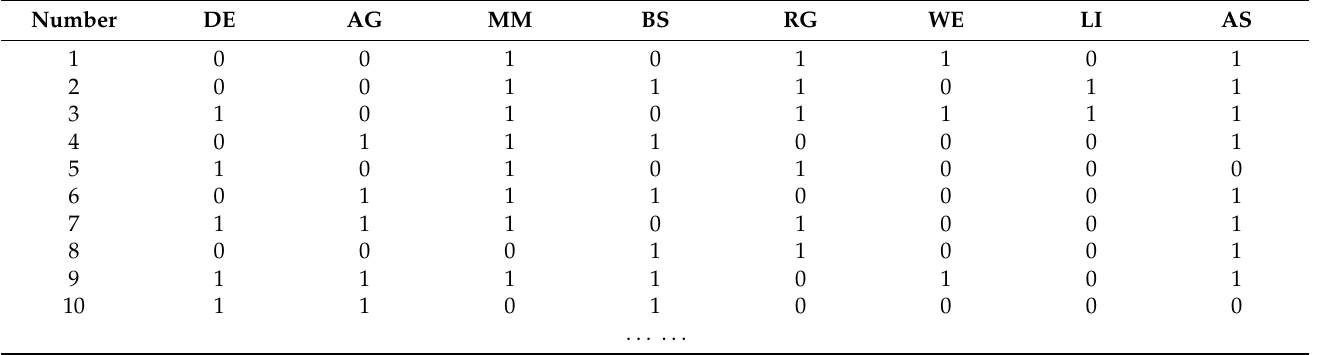
Table 3. Truth table of safety accidents